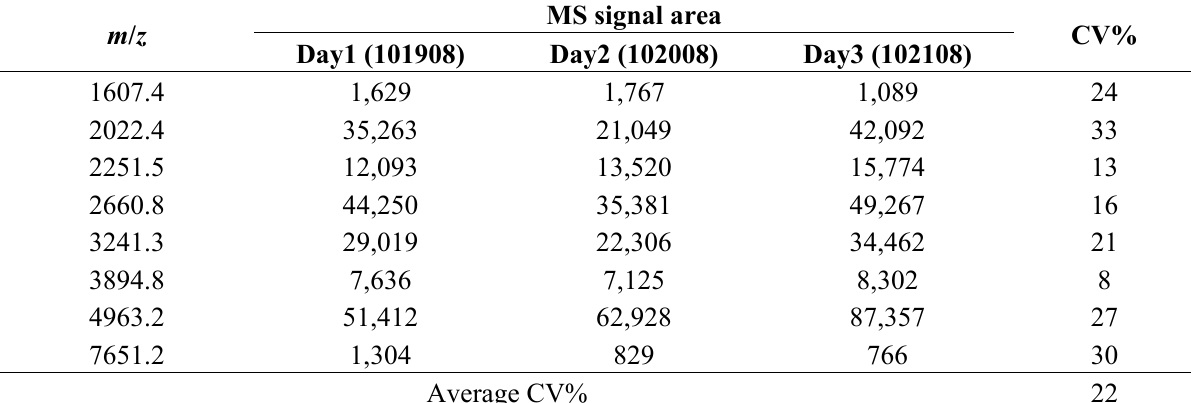
Table 4. Inter-day variability of MALDI-TOF MS after sample preparation with IMAC-Cu beads.